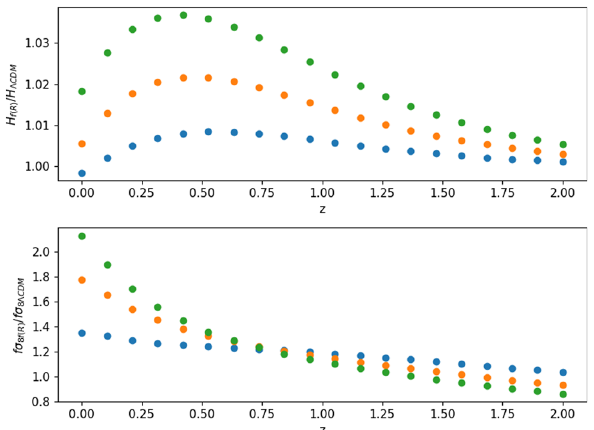
Fig. 9 Comparison of the evolution of the ratio of observables in the Starobinsnky f ( R ) models and their Λ CDM values. Each point is the theoretical prediction for a given redshift. Different colored curves cor- respond to different values of the model parameter, λ − 1 = 0 . 3 , 0 . 7 , 1 ) , with Ω m 0 = 0 . 3 and n = 1